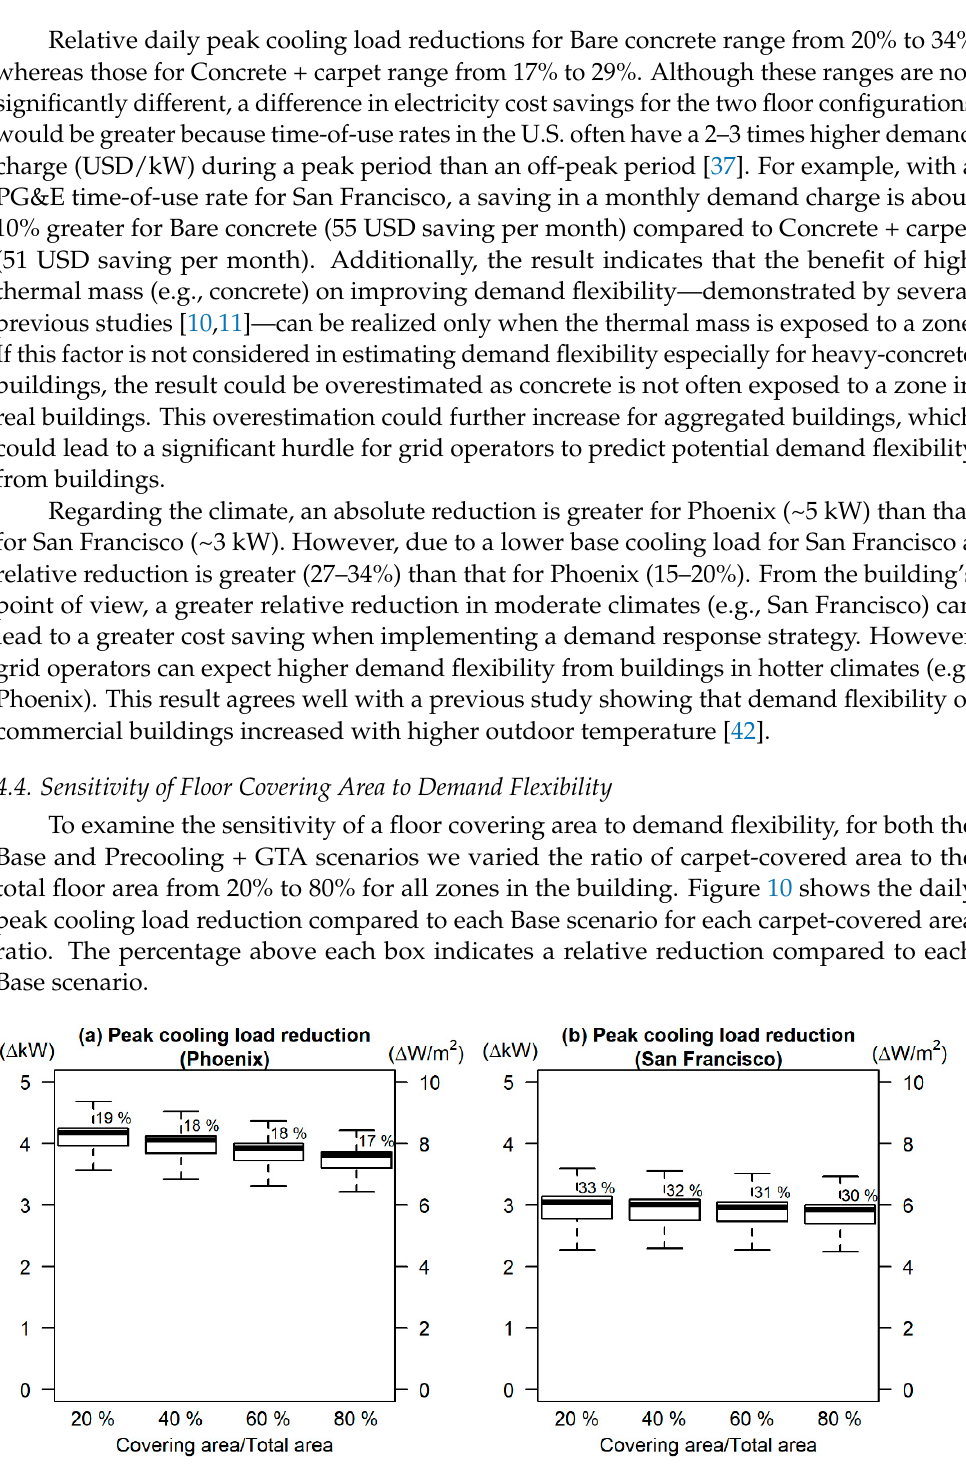
Figure 10. Sensitivity of the carpet-covered area to the peak cooling load reduction for a concrete floor in ( a ) Phoenix, AZ and ( b ) San Francisco, CA. The ratio of the carpet-covered area to the total area was varied from 20% to 80% uniformly across all zones in the building. The peak cooling load reductions were estimated during 106 weekdays from 1 June to 31 October. The percentage above a box indicates the median of relative reductions compared to the Base